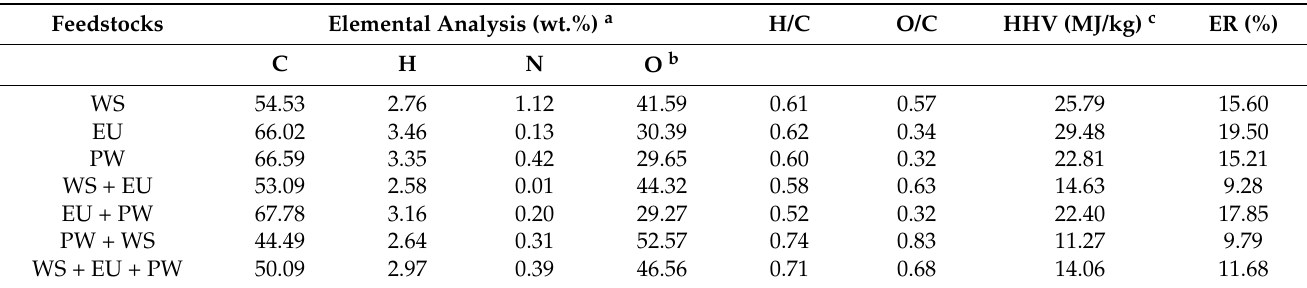
Table 4. Elemental analysis of solid